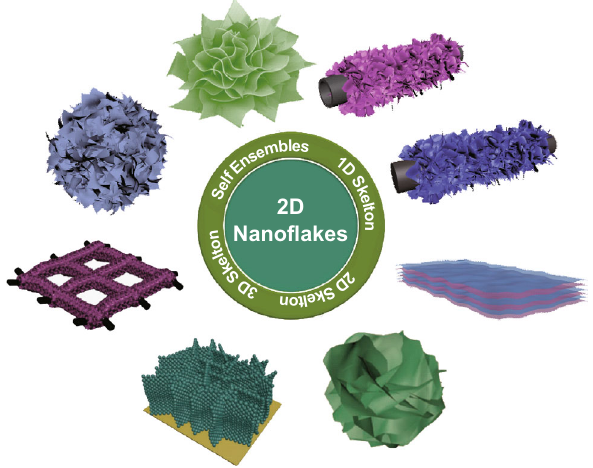
Fig. 1 Schematic illustration of 3D architecture-based 2D nanoflake